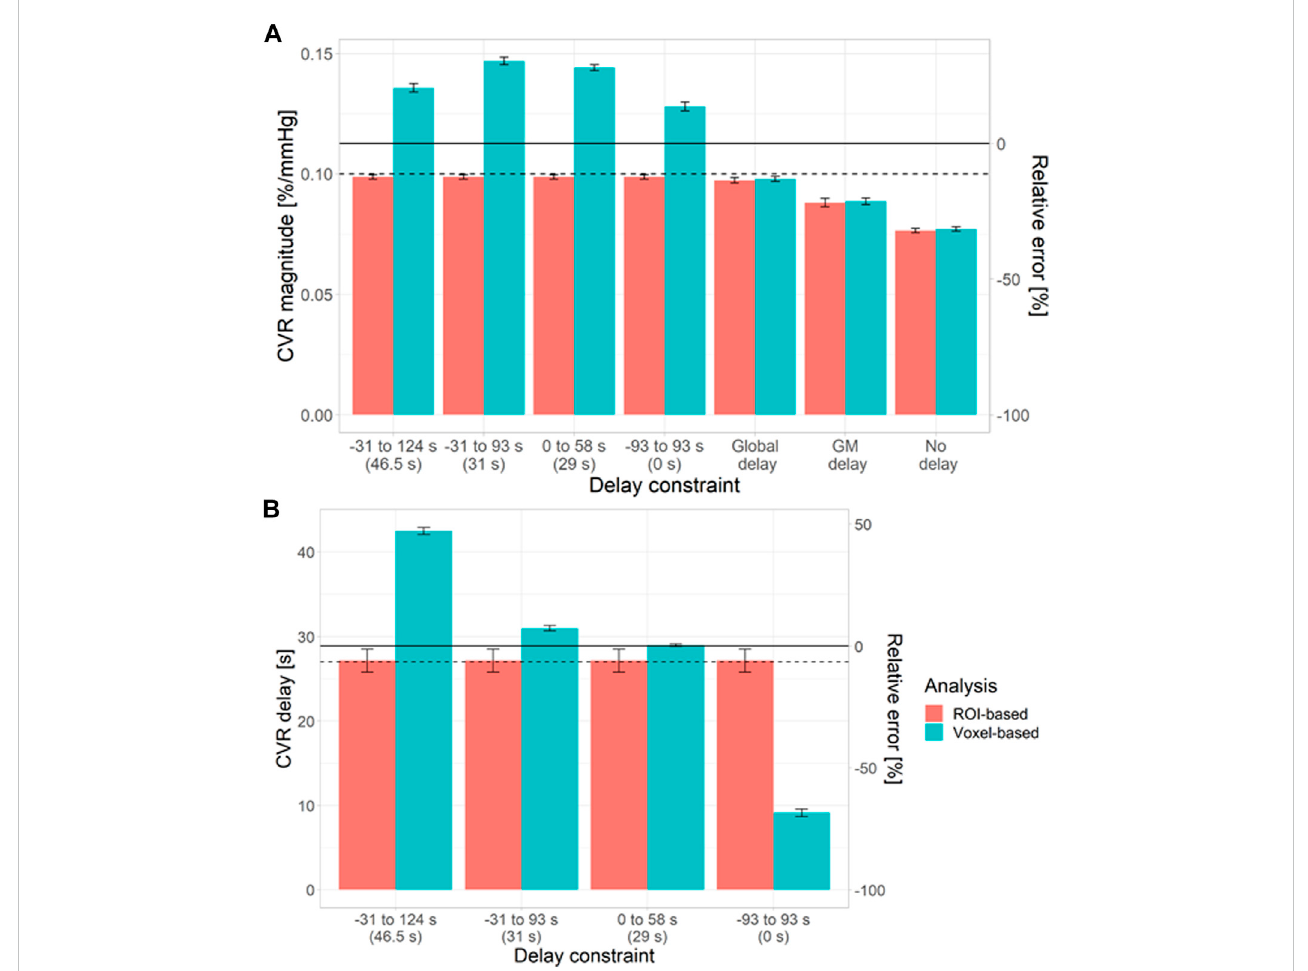
FIGURE 3 Simulations showing the impactof the delay constraint and assumption of fi xed delay at a voxel tCNR of 0.1 on the estimation of CVR magnitude (A) and delay (B) in NAWM. The bars and error bars correspond to the mean and standard deviation respectively of the CVR estimates across 1000 repetitions for the voxel- (blue) and ROI-based (pink) analyses. Horizontal solid and dashed lines represent the ground-truth mean and median values, respectively. The relative errorswerecomputedwithrespecttotheground-truthmeanvalues.Thecentralvaluesforeachdelayconstraintareshowninparentheses.(ROI:region of interest, GM: grey matter, NAWM: normal-appearing white